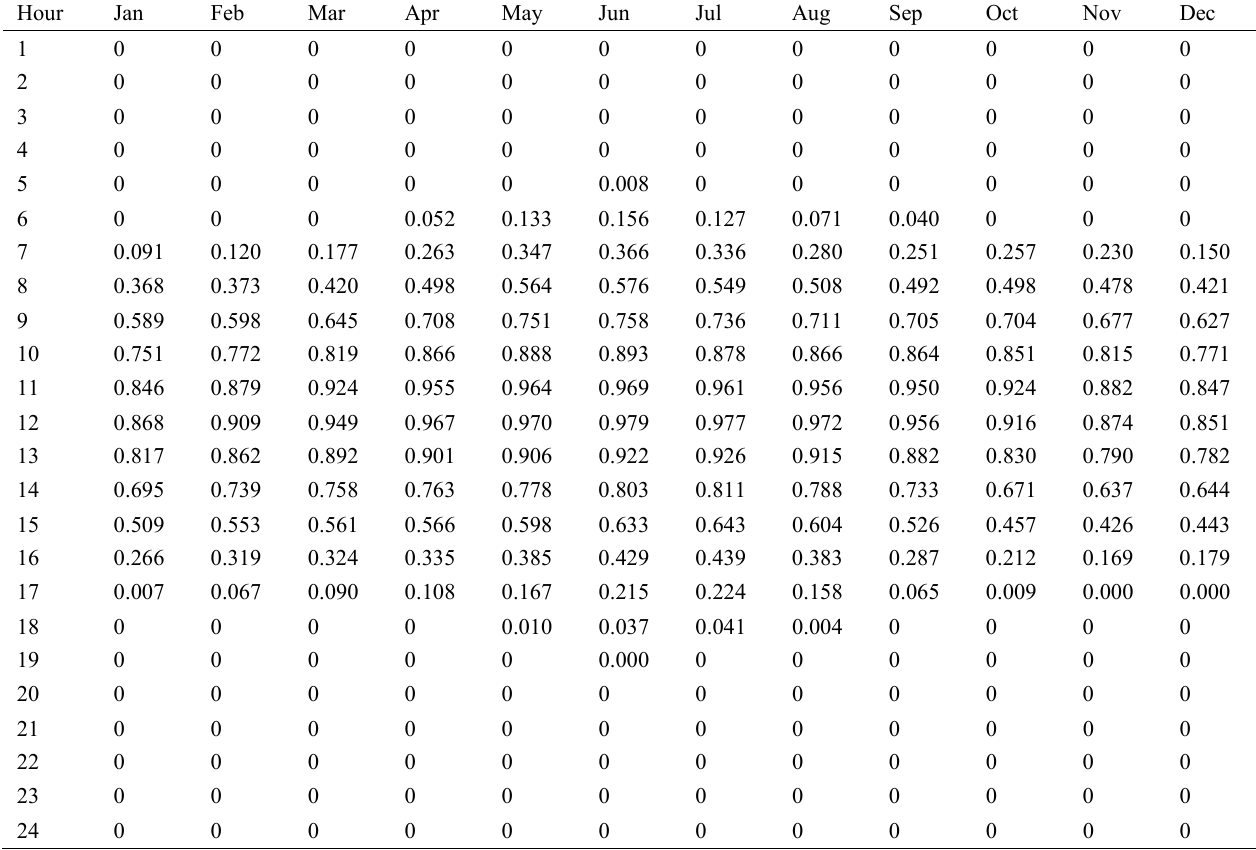
Table 10. Optimized solar radiation data for New Delhi city in kW/m 2